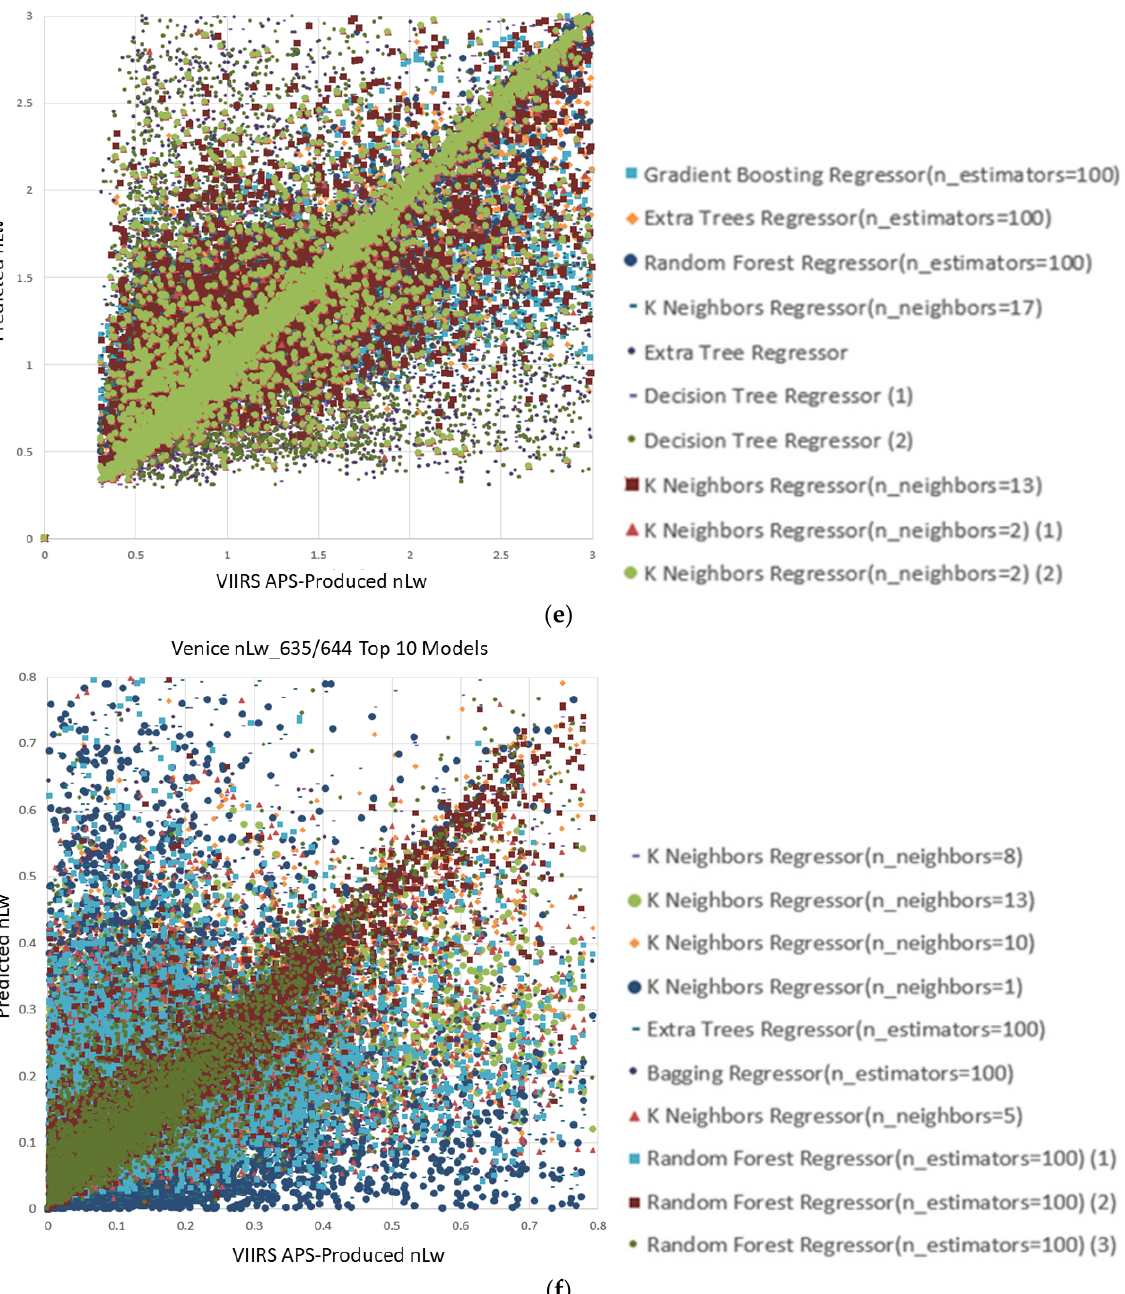
Figure 7. ( a ). VIIRS top 10 nLw predictive models compared to the real (APS-processed) nLw_494 at the MOBY study area. ( b ). VIIRS top 10 nLw predictive models compared to the real (APS-processed) nLw_545 at the MOBY study area. ( c ). VIIRS top 10 nLw predictive models compared to the real (APS-processed) nLw_636/644 at the MOBY study area. ( d ). VIIRS top 10 nLw predictive models compared to the real (APS-processed) nLw_494 at the Venice study area. ( e ). VIIRS top 10 nLw predictive models compared to the real (APS-processed) nLw_545 at the Venice study area. ( f ). VIIRS top 10 nLw predictive models compared to the real (APS-processed) nLw_635/644 at the Venice study area.